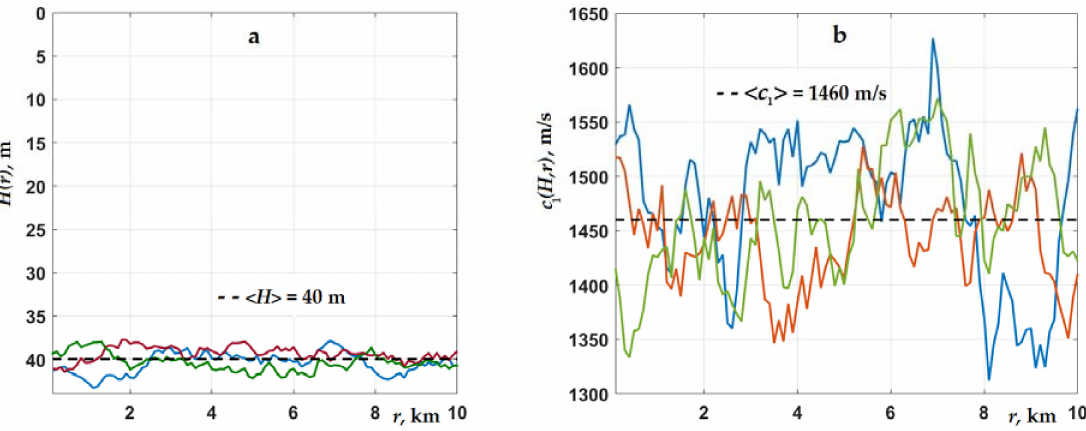
Figure 1. Illustration of a stochastic waveguide model. ( a )—three random realizations of waveguide bathymetry fluctuations; ( b )—three random realizations of fluctuations in the speed of sound c 1 at the interface z = H ( r ). L rc = L h = 1